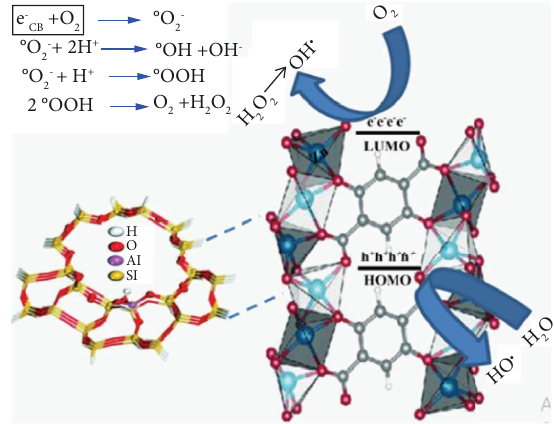
− ) generation and dye oxidation process modifed from [59]. 2